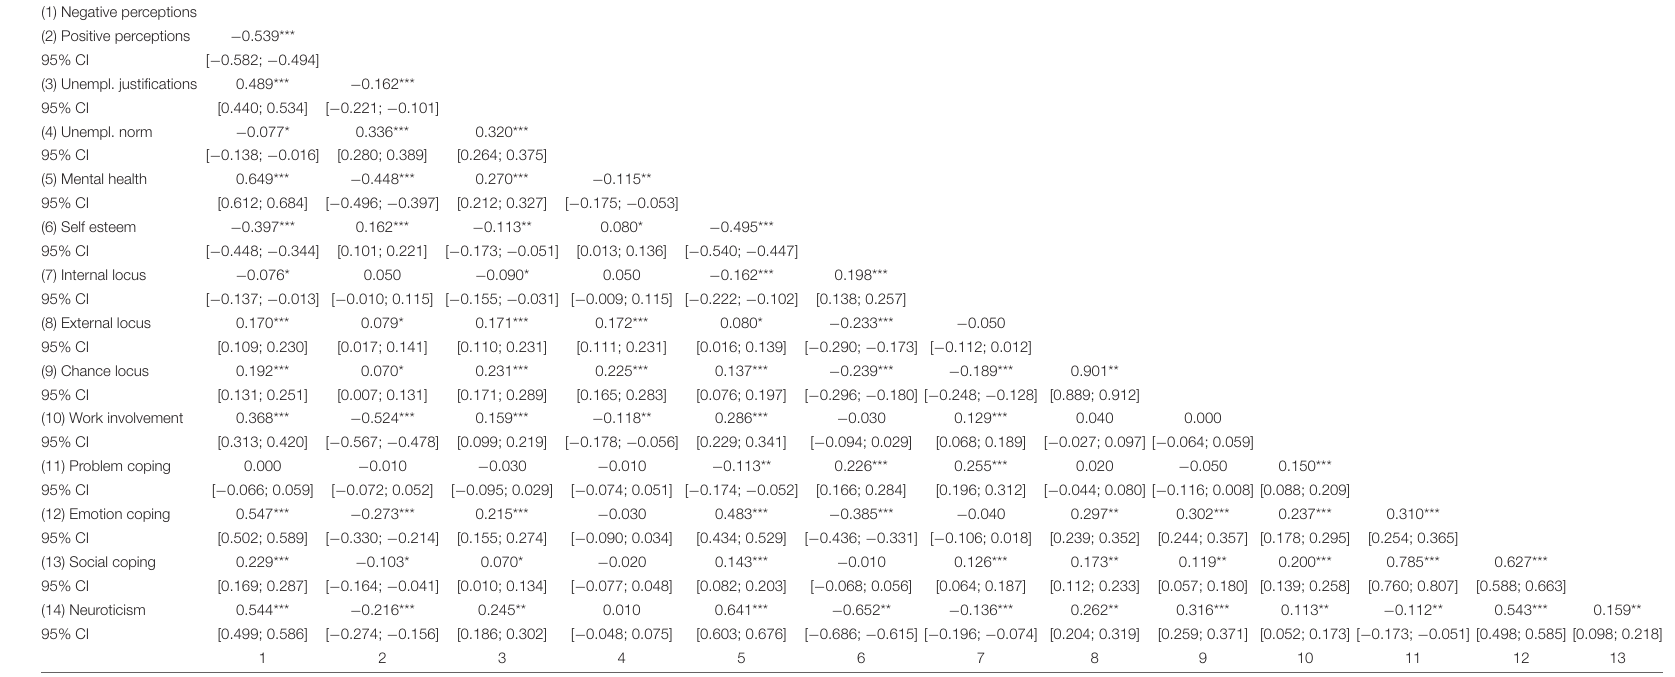
TABLE 2 | Correlations between normalization dimensions and psychological variables. (1) Negative perceptions (2) Positive